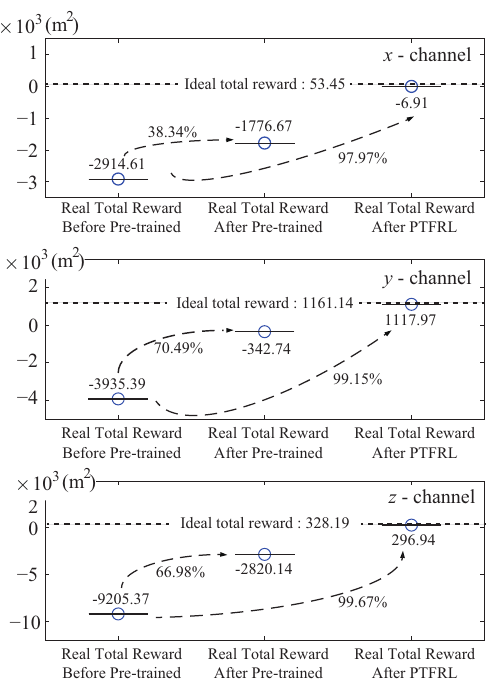
Figure 9. Comparisons of total rewards in different